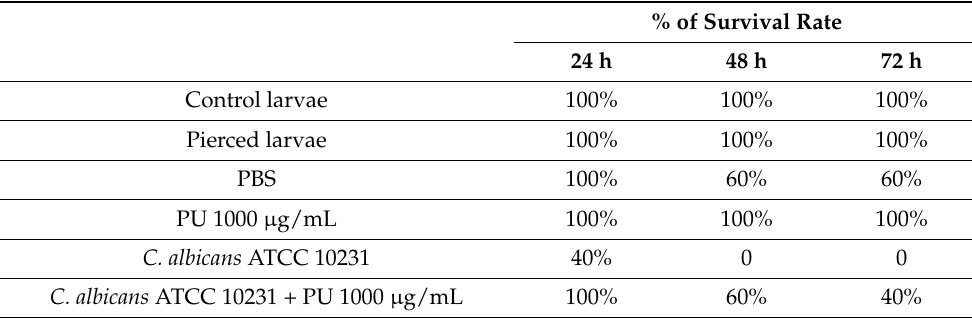
Table 4. % of survival rate of G. mellonella infected with C. albicans and treated with PU after 24, 48 and 72 h of